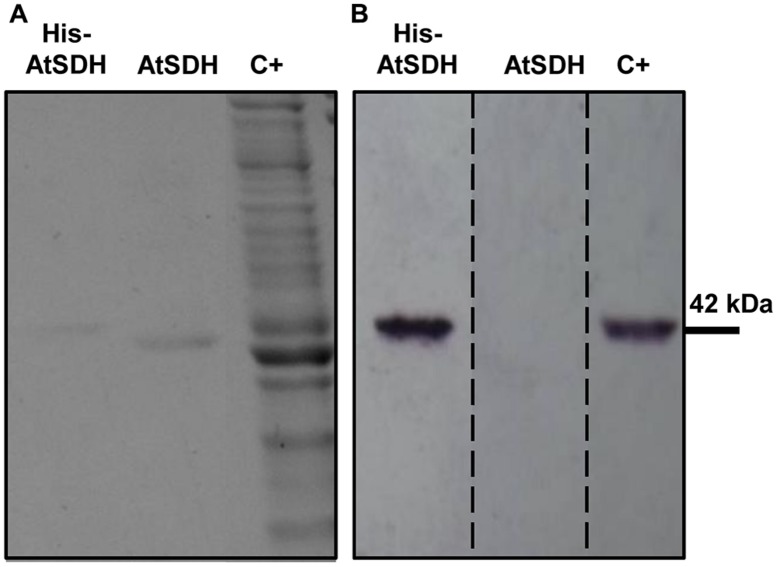
Expression and purification of recombinant His-AtSDH and AtSDH. (A) Coomassie stained gels containing purified recombinant AtSDH, before (lanes His-AtSDH) and after (lanes AtSDH) TEV-mediated cleavage of the His-tag; note the difference in migration of recombinant His-AtSDH vs. AtSDH. C+; whole reaction products from the in vitro expression of recombinant His-AtSDH. (B) Immunoblot analysis of the samples in (A), using an anti-His antisera. The dashed lines denote that this image is a reconstruction of the original immunoblot, which is shown in Supplementary Figure S1.